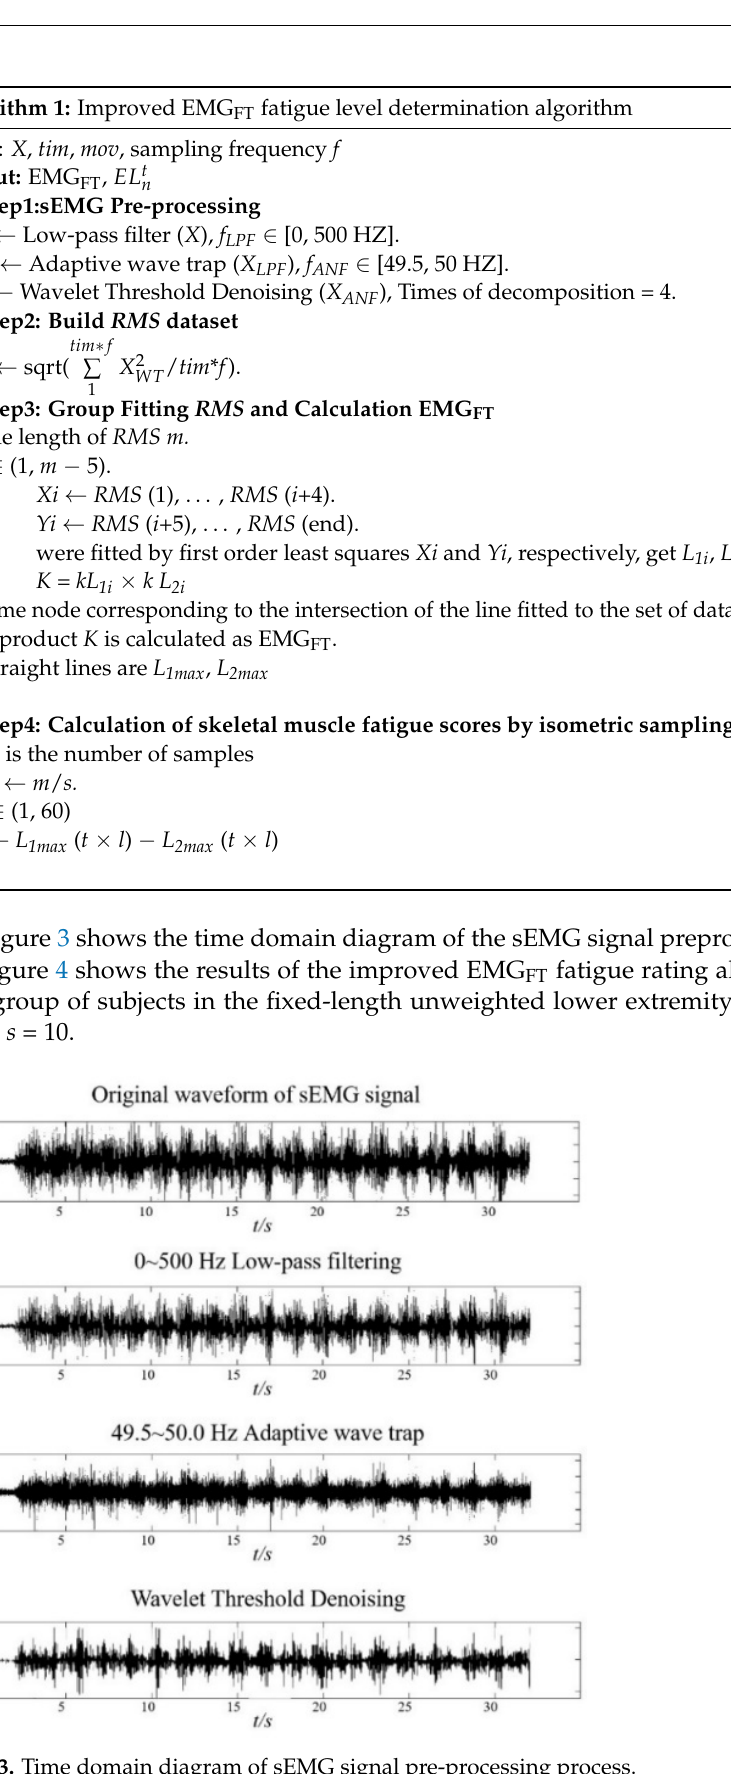
Figure 4. The result of improved EMG FT fatigue level determination algorithm. As can be seen from Figure 4, the RMS values of the subjects during exercise showed an increasing trend with the onset of fatigue, the EMG FT of RF appeared before the EMG FT of TA, the fatigue time of TA was 29.6 s, and the fatigue time of RF was 15.3 s. The Joint comfort index extraction The stability of the hip, knee, and ankle joints during fixed-length unweighted lower- body squats was correlated with the fatigue and comfort level of the subjects. The longer the exercise time, the lower the joint stability, the higher the fatigue, and the lower the comfort level [32]. In order to evaluate the comfort level of lower limb joints, this paper